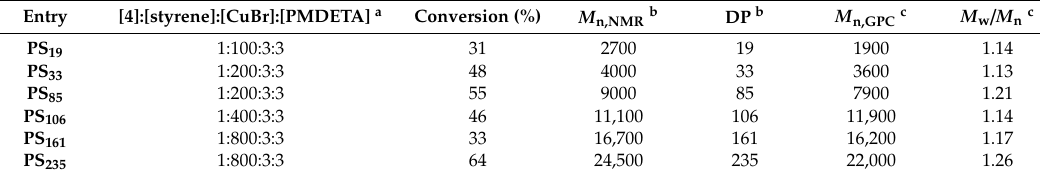
Table 1. Results and optimized conditions for ATRP of styrene using 4 .